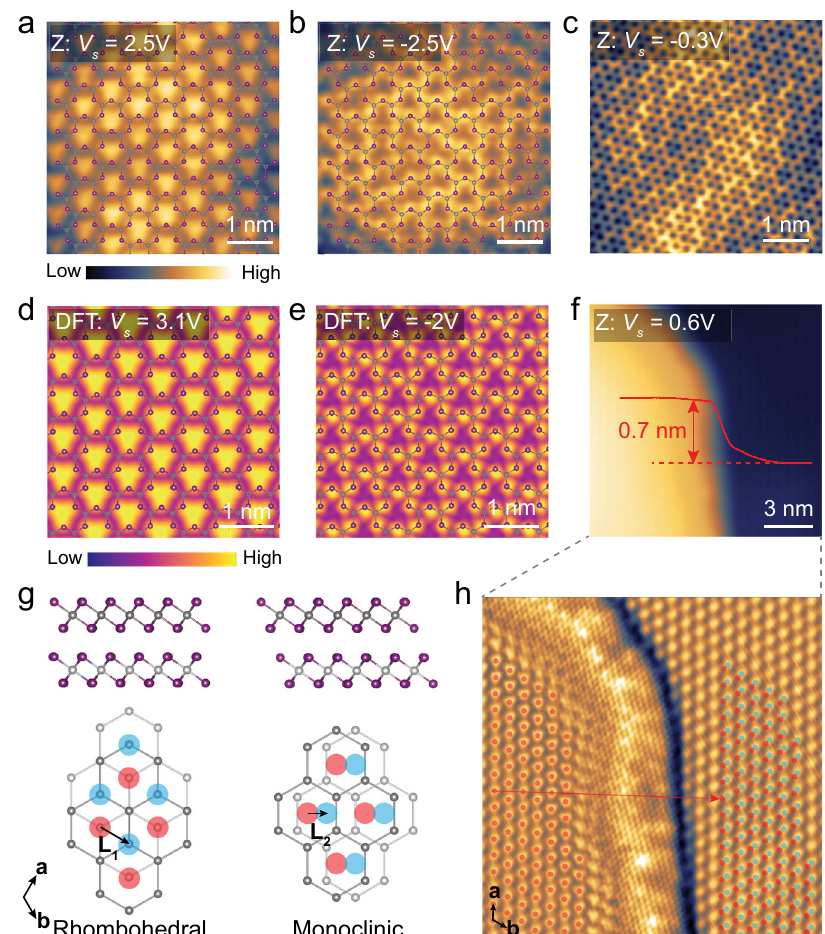
Fig. 3 STM measurements of G/FL-CrI 3 /Gr. a – c Bias-dependent STM images of G/FL-CrI 3 /Gr. STM images taken at ( a ) V s = 2.5 V and ( b ) at V s = − 2.5 V with the superimposed atomic structure of ML-CrI 3 (I atoms on the bottom atomic plane are removed for clarity). STM images taken at ( c ) V s = − 0.3 V. The tunneling current is I t = 1 nA. d , e Simulated STM images taken at ( d ) V s = 3.1 V and ( e ) V s = − 2 V with the superimposed atomic structure of ML-CrI 3 . f STM image acquired across the single-layer step of CrI 3 ( V s = 0.6 V, I t = 0.2 nA). g The atomic structure of adjacent CrI 3 layers with rhombohedral stacking and monoclinic stacking. The upper (lower) panels are side (top) views. The top view shows the honeycomb lattice formed by Cr atoms (I atoms are removed for clarity), where the center of each hexagon in the upper (lower) layer is indicated by the red (blue) circle. h The processed STM image of f by using edge enhancement fi lters to better visualize the atomic lattice of both layers. The lattice of the upper (lower) layer is represented by the red (blue) circle. To intuitively show the atomic translation between two layers, a replica of the upper-layer lattice (translated by (8 a + 16 b ) with respect to the original lattice of the upper layer) is shown as the red circle on the lower layer. The red arrow represents the vector (8 a + 16 b